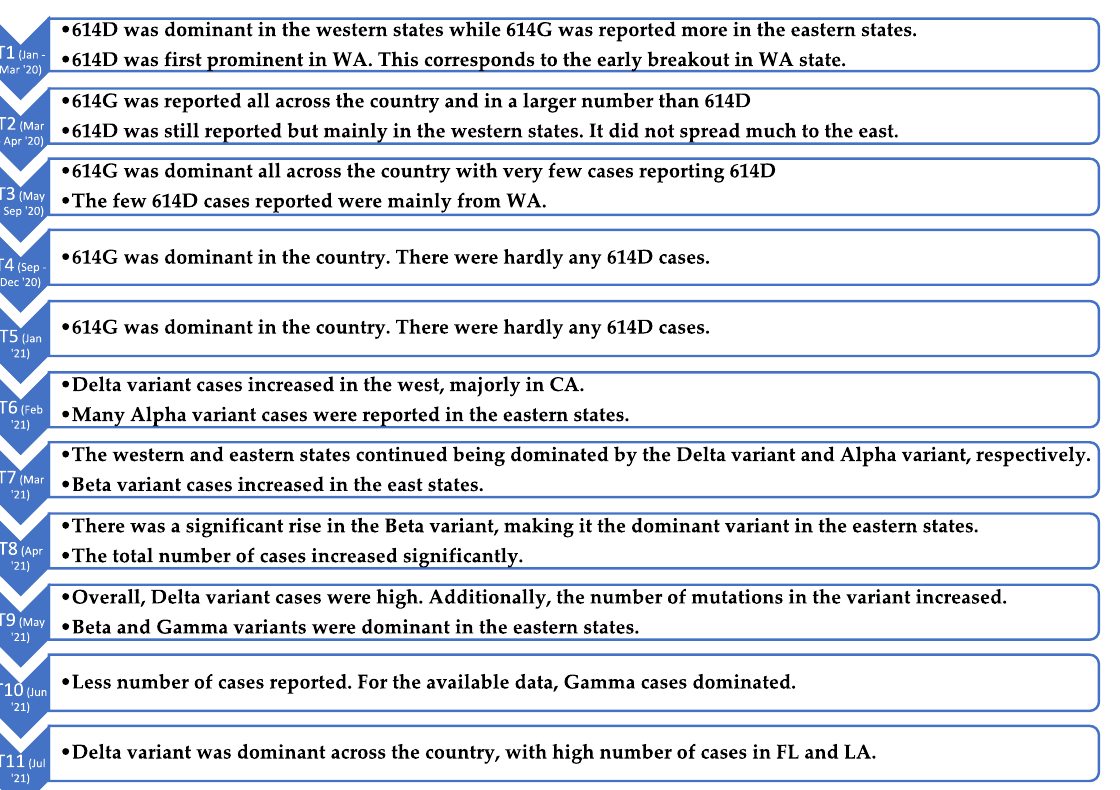
Figure 9. Timeline summarizing the observed trends in the time periods T1 – T11.